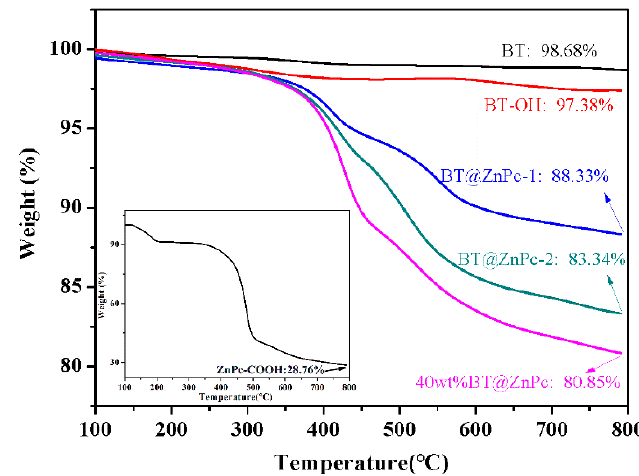
Figure 3. Thermogravimetric analysis (TGA) curves of BT, BT-OH, ZnPc-COOH, BT@ZnPc-1,